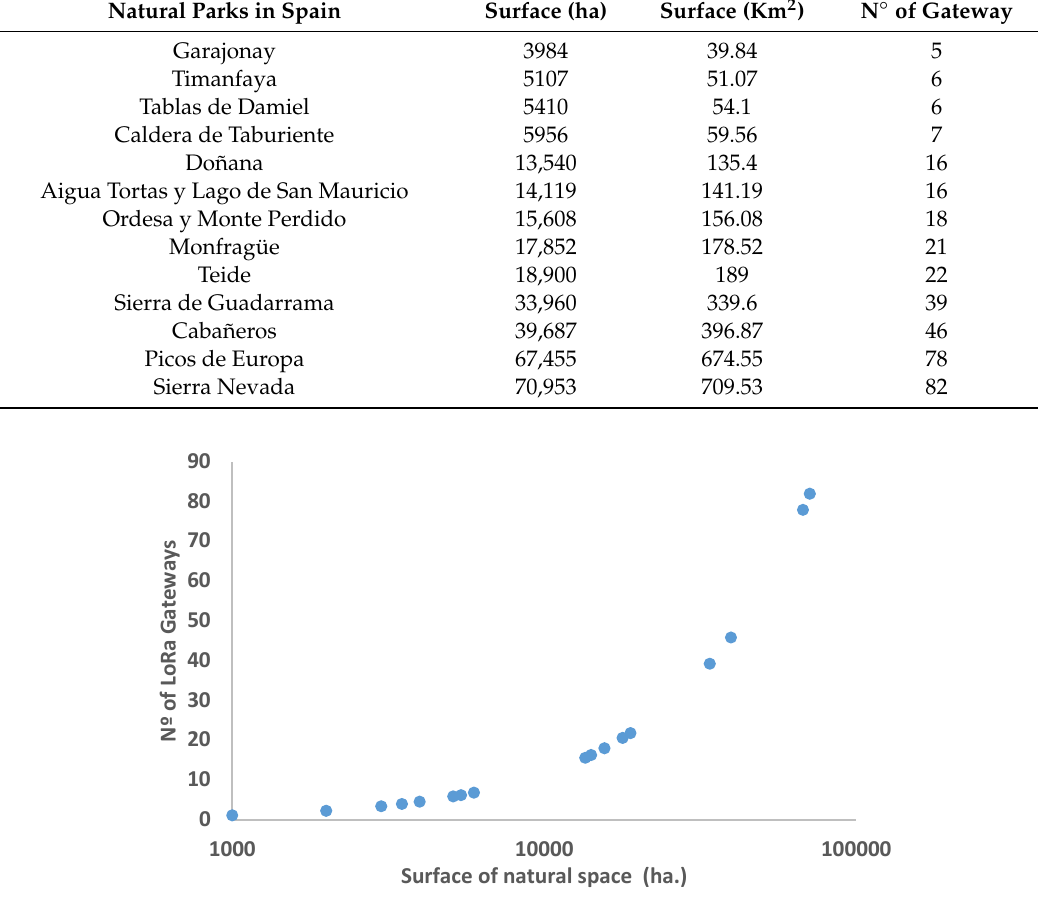
Table 7. Protected natural parks in Spain and their surface.